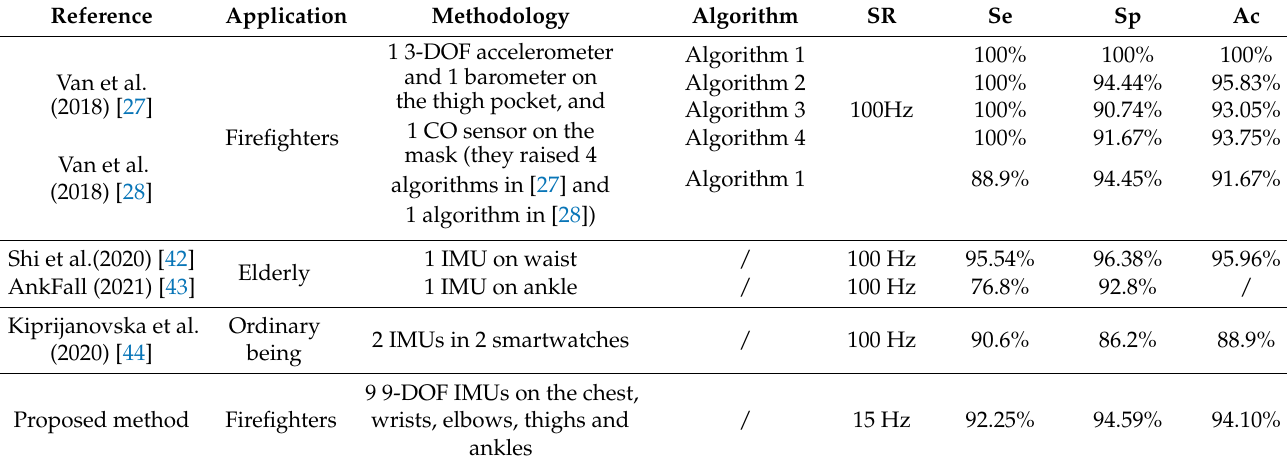
Table 6. Comparison of fall-detection results with the proposed FDS and some previously developed FDSs, where SR, Se, Sp, and Acc represent the sampling rate of IMUs, sensitivity, specificity, and accuracy,